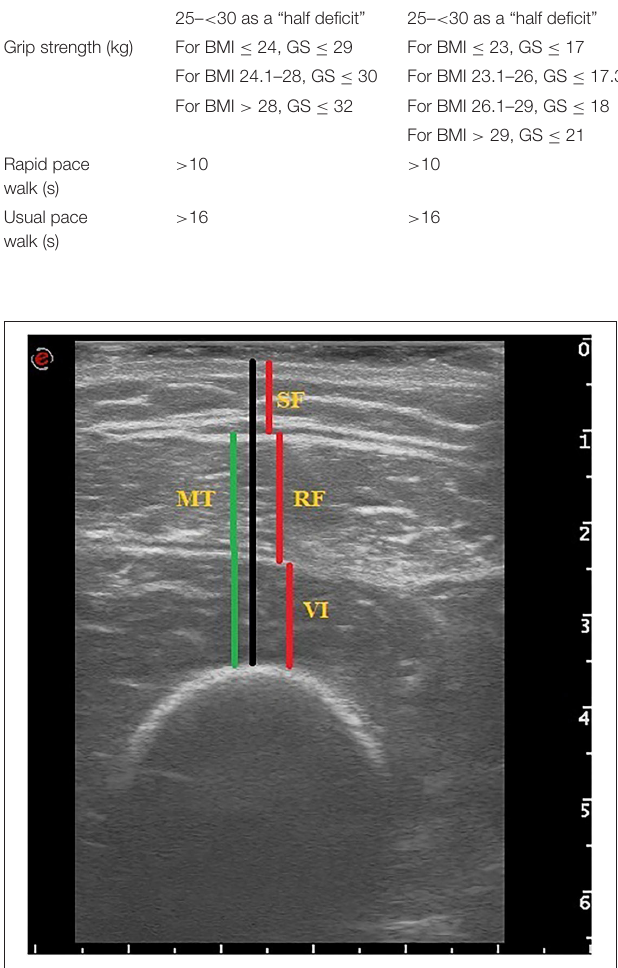
FIGURE 1 | Representative image of muscle ultrasound. Muscle thickness (MT) was defined as the mean value of three measurements of the sum of the distance between the anterior fascia and the posterior fascia of the rectus femoris (RF) and the vastus intermedius (VI) muscles. SF, subcutaneous fat.